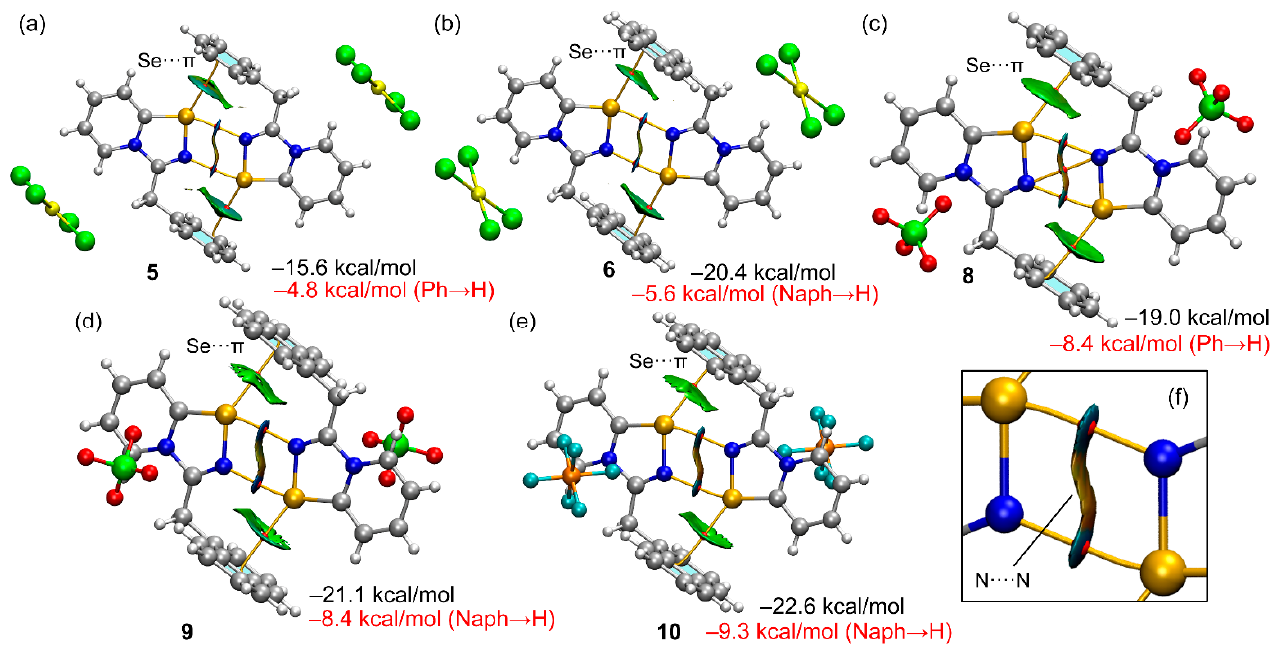
Figure 4. Combined QTAIM (CPs in red and bond paths as orange lines) and NCIPlot analyses of the dimers of 5 ( a ) 6 ( b ), 8 ( c ), 9 ( d ), and 10 ( e ) and an amplification of the Se···N interaction ( f ). The dimerization energies using the X-ray geometries and the mutated dimers are indicated using black and red font, respectively. Isovalue for the RDG isosurface 0.45.